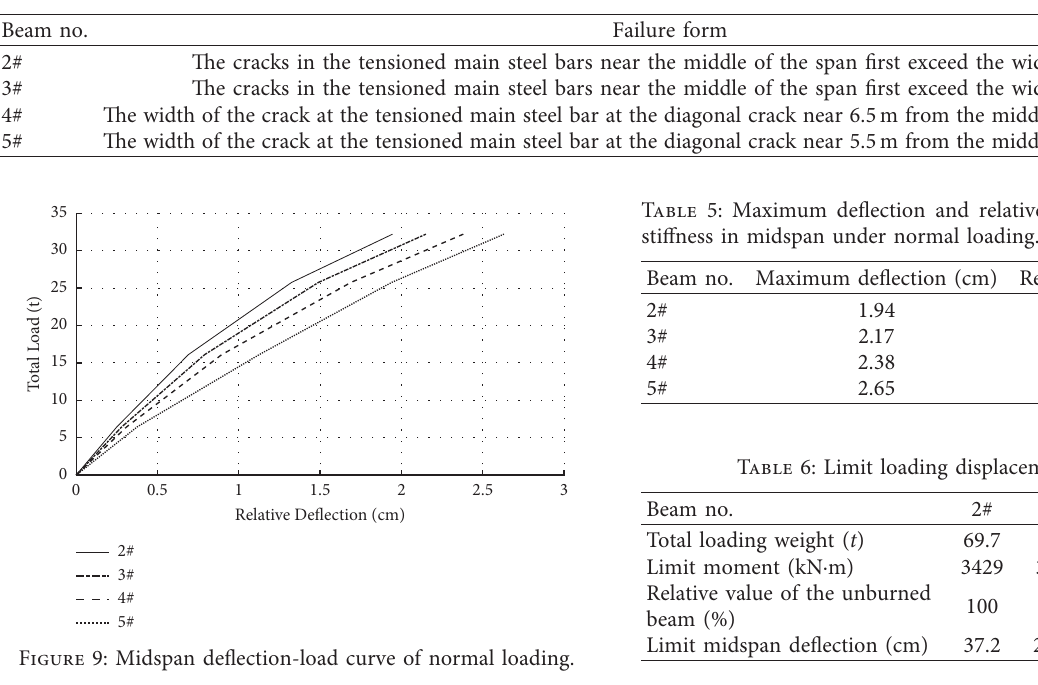
Figure 8: The typical failure pattern. (a) No. 2#. (b) No. 3#. (c) No. 4#. (d) No. 5#. Table 4: The failure mode of test beams.